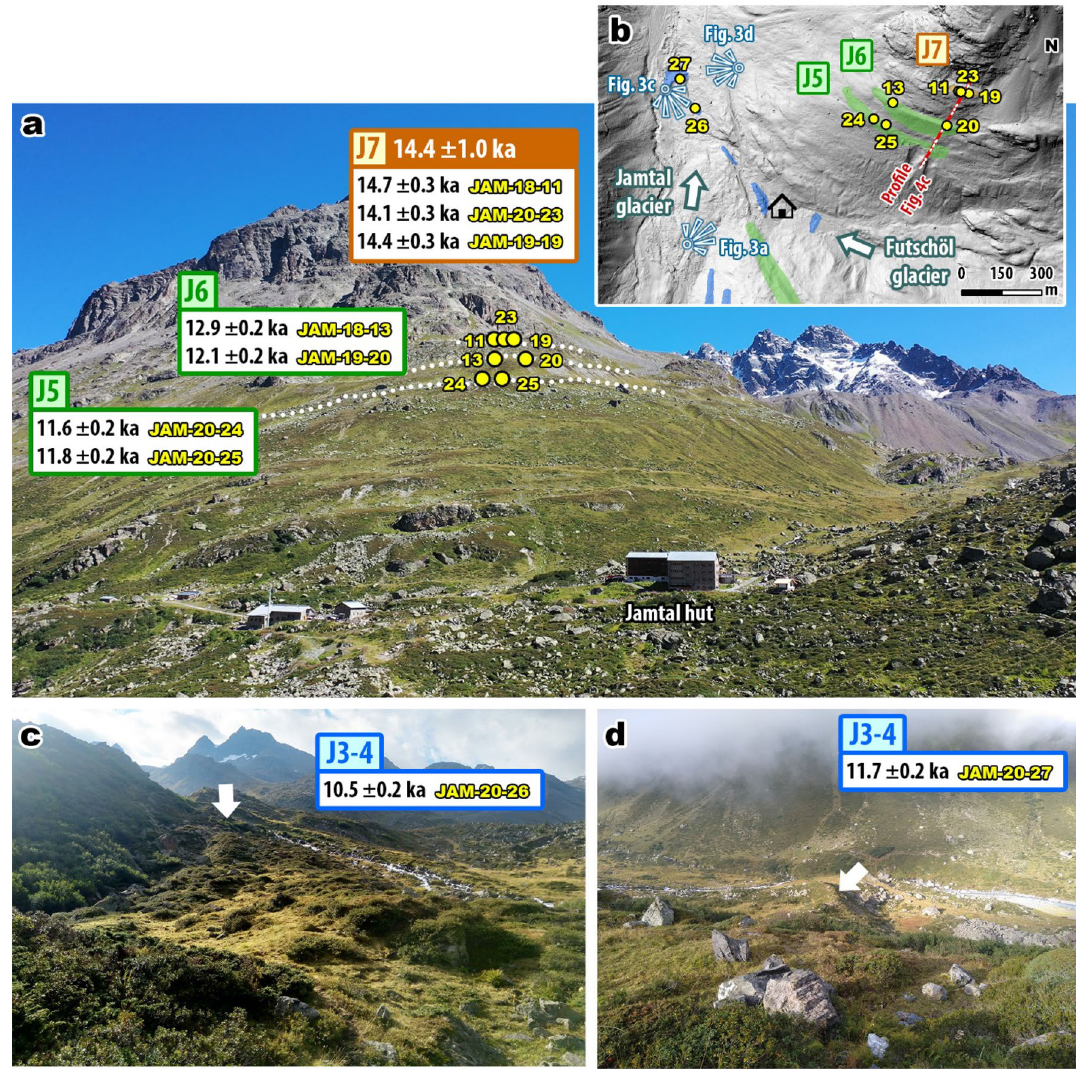
Figure 3. Photographs and map of sampled valley sections at Jamtal. (a) Moraine sequence (dotted lines) evidence confluence of tributary (Futschöl) glacier with the main (Jamtal) glacier during the LG. The uppermost landform J7 indicates an ice margin position during (pre-)Bølling times. Moraines J6 and J5 were deposited during the YD and suggest a lowering of the ice surface of ca. 55 m from the early YD to its end. (b) Map showing sample and landform locations at Jamtal (DEM provided by Land Tirol—www. tirol. gv. at/ als, CC BY 4.0; map was created using ArcGIS v10.7). (c) Lateral moraine set deposited during the EH. The inner of two ridges (arrow) features boulder age JAM-20-26 and is (due to its position) several centuries younger compared to (d) sample JAM-20-27 taken from the terminal section of J3–4. The statistically identical ages of J5 and JAM-20-27 suggest that the valley flank displayed in ( a ) deglaciated within centuries during the YD–EH